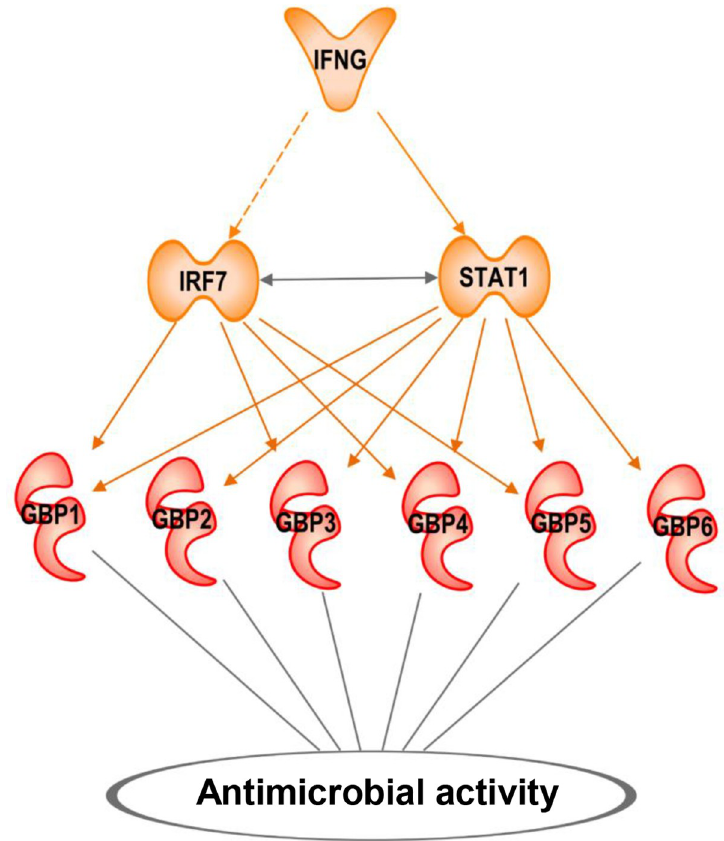
Fig 7. IFN- γ is the major upstream regulator for GBP expression in the RR peripheral blood. IPA pathway and path designer were used to create a functional IFNG downstream causal network. Upstream regulators with predicted activation are in orange and RR downstream upregulated GBPs are in red. Bold lines mean direct activation and dotted lines mean indirect activation.